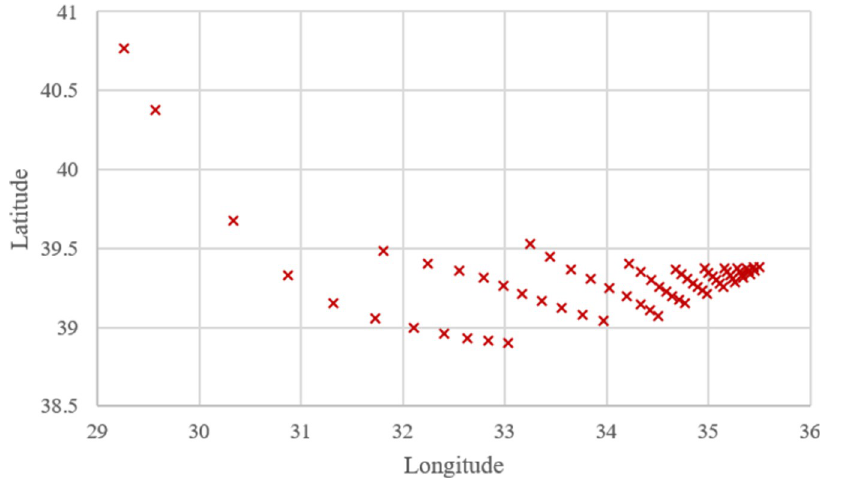
Fig 6. Optimum locations computed for 66 cases using